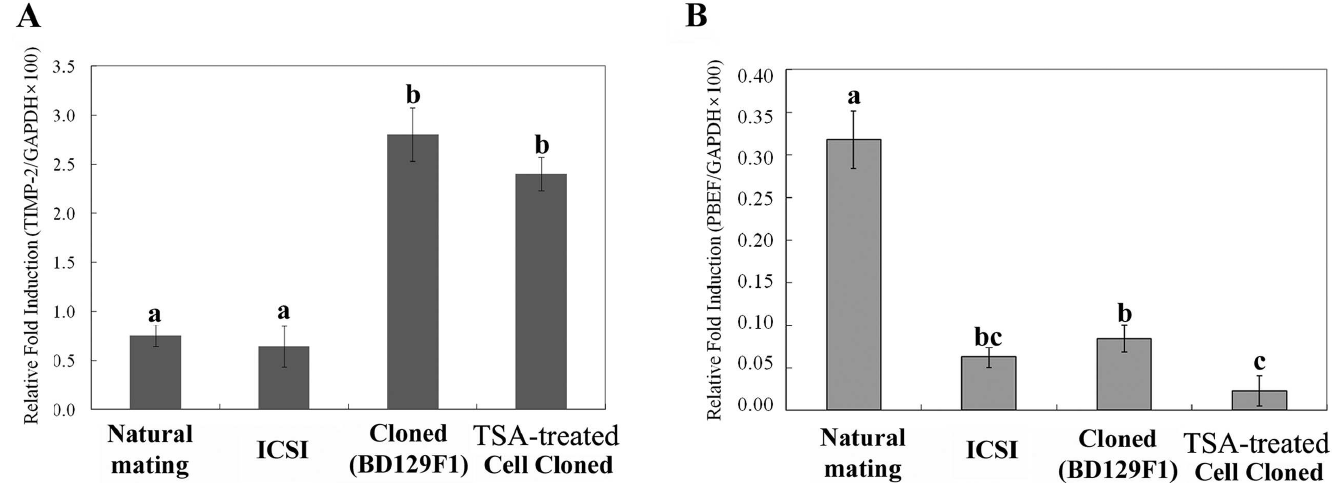
Fig 3. The mRNA expression levels of TIMP-2 and PBEF in NM control, ICSI-derived, cloned, and TSA-treated cloned placentae. (A) TIMP-2 mRNA level (relative fold induction)in RT-PCR. (F) PBEF mRNA level (relative fold induction)in RT-PCR. Four replicates were performed. The mean of expressionlevels with different superscripts (a-c) differ significantly (P < 0.05). Error bars show the standarderror (SE).